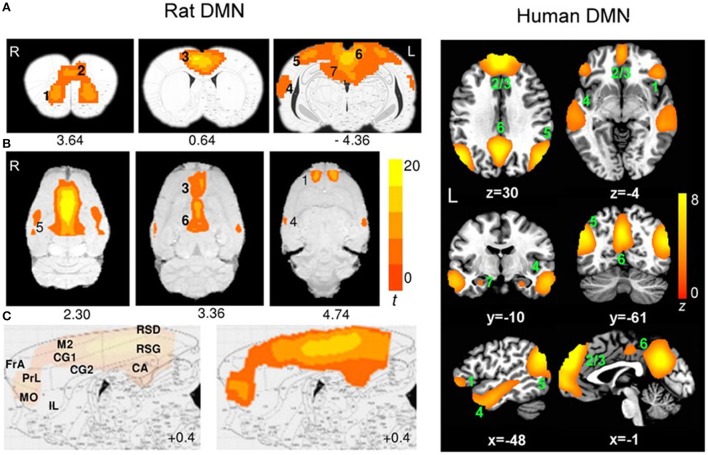
Evidence of translatability of fMRI studies: similar brain regions forming part of the default mode network (DMN) in the rat (Paxino's atlas coordinates indicated) and human (Talairach coordinates indicated) brains. Connectivity maps are shown in the coronal (A), axial (B), and sagittal (C) planes. Significant clusters for rat DMN (left) include: 1, orbital cortex; 2, prelimbic cortex (PrL); 3, cingulate cortex (CG1, CG2); 4, auditory/temporal association cortex (Au1, AuD, AuV, TeA); 5, posterior parietal cortex; 6, retrosplenial cortex (corresponding to the posterior cingulate cortex in humans); 7, hippocampus (CA1). The sagittal plane (medial–lateral: +0.4 mm) also shows: FrA, frontal association cortex; MO, medial orbital cortex; RSG/RSD, granular/dysgranular retrosplenial cortex. Color bar indicates t scores (n = 16, t > 5.6, corrected p < 0.05). Significant clusters for human DMN (right) include: 1, orbital frontal cortex; 2/3, medial prefrontal cortex/anterior cingulate cortex; 4, lateral temporal cortex; 5, inferior parietal lobe; 6, posterior cingulate cortex; 7, hippocampus/parahippocampal cortex. Color bar indicates z scores (n = 39, z > 2.1, corrected p < 0.05). Image adapted from Lu et al. (2012), an open access article under the creative commons license and can be republished without the need to apply for permission provided the material is cited correctly and is republished under the same license.